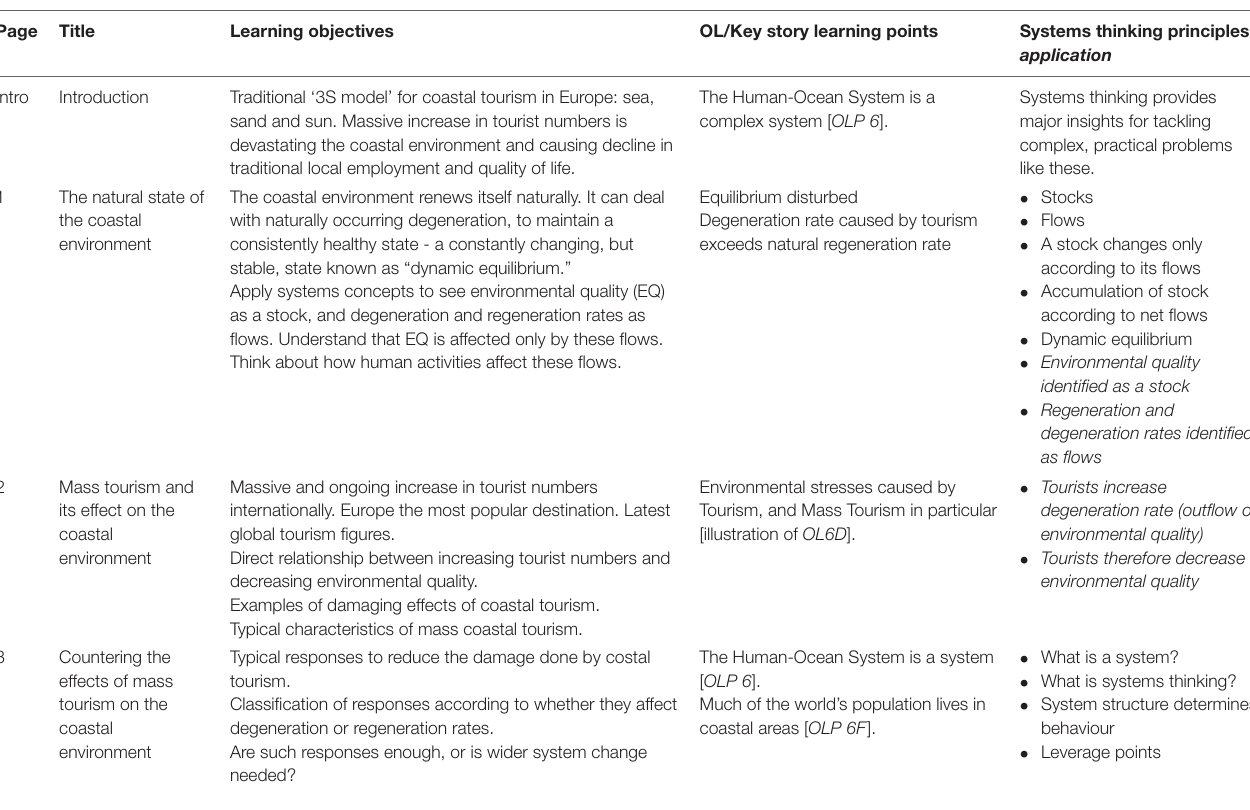
TABLE 1 | Ocean literacy and systems thinking learning objectives identified (part